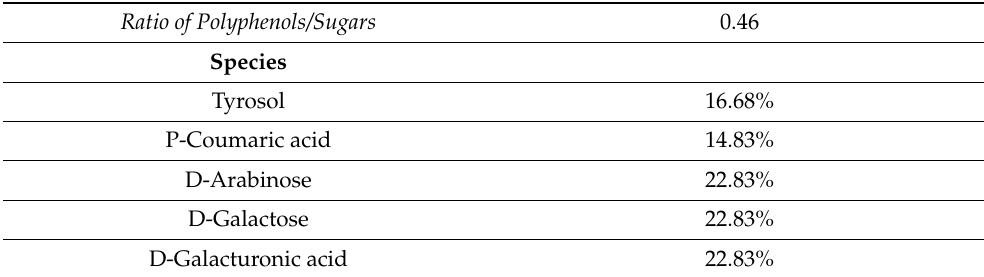
Table 2. Typical composition (wt.%) on a dry basis of the OMW. Reprinted with permission from Ref. [36]. Copyright 2022 John Wiley and